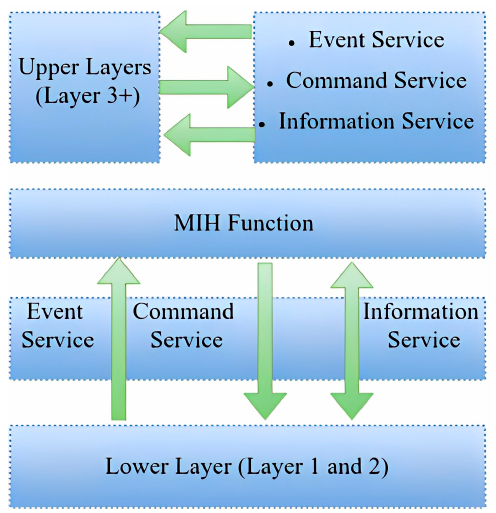
Figure 4. Media-Independent Handover, MIH [17].